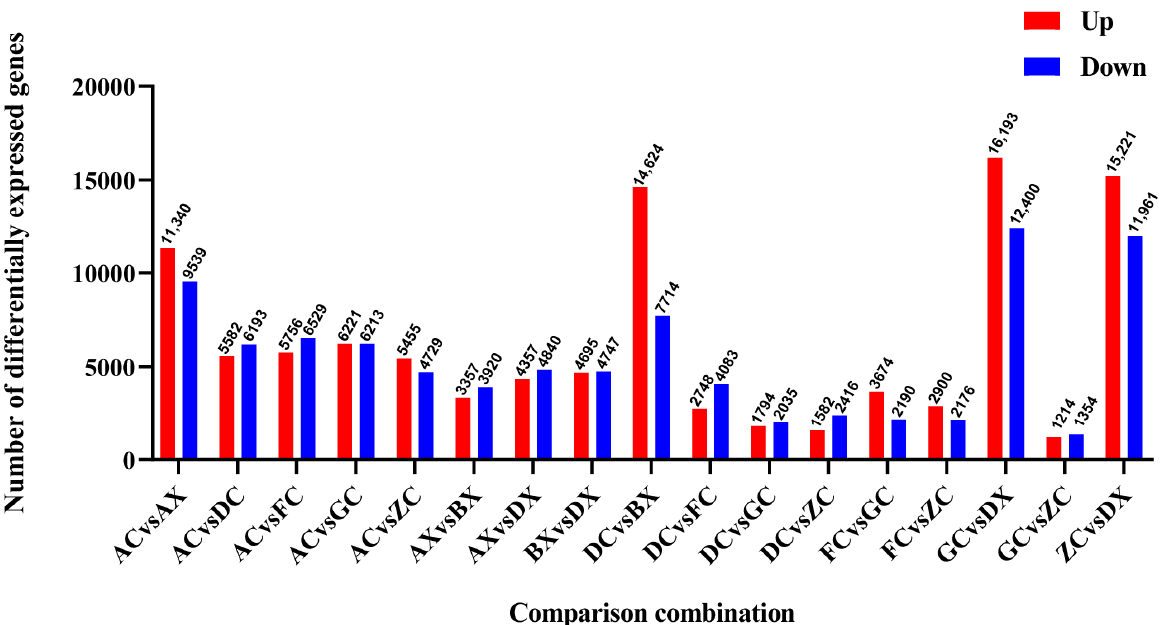
Figure 4. Statistics of differentially expressed genes in different stages of gonadal development of